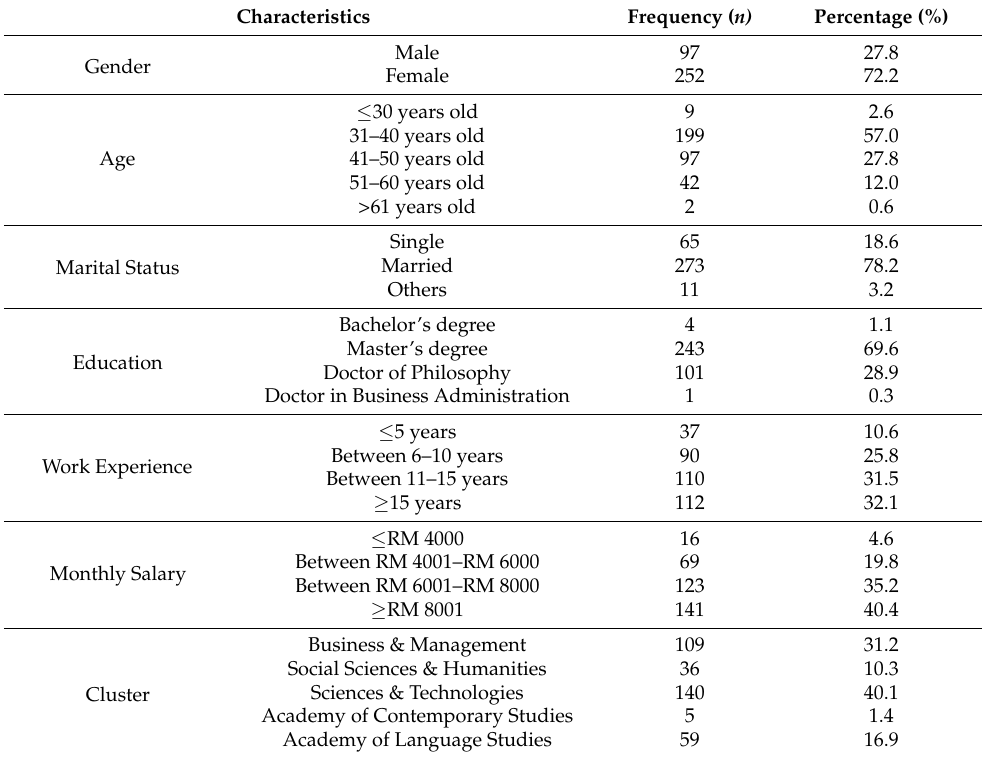
Table 1. The respondents’ profiles.